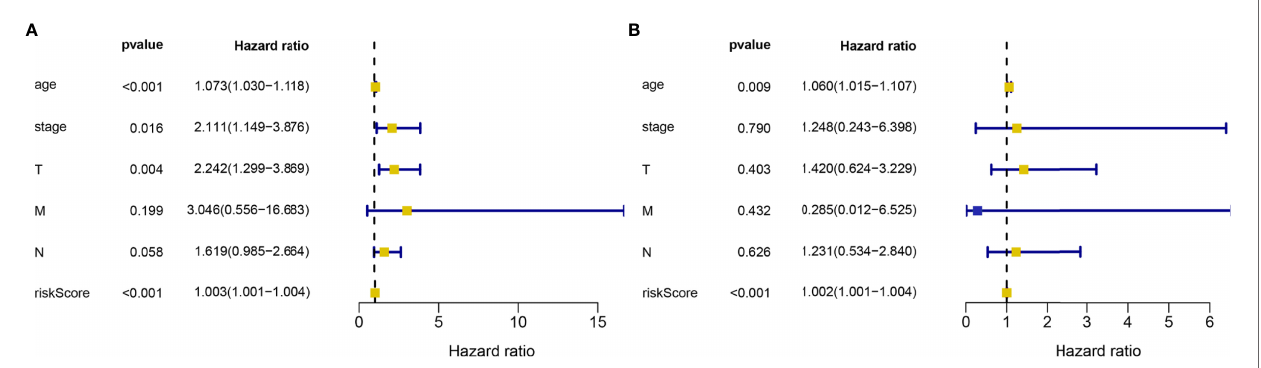
FIGURE 5 | Univariate (A) and multivariate (B) analysis of risk score and clinical data related to HER2-positive breast cancer samples in TCGA database. The squares represent HR values, khaki means HR>1, blue means HR<1.The blue line represents the 95% con fi dence interval. A total of 133 HER2-positive samples were included in the